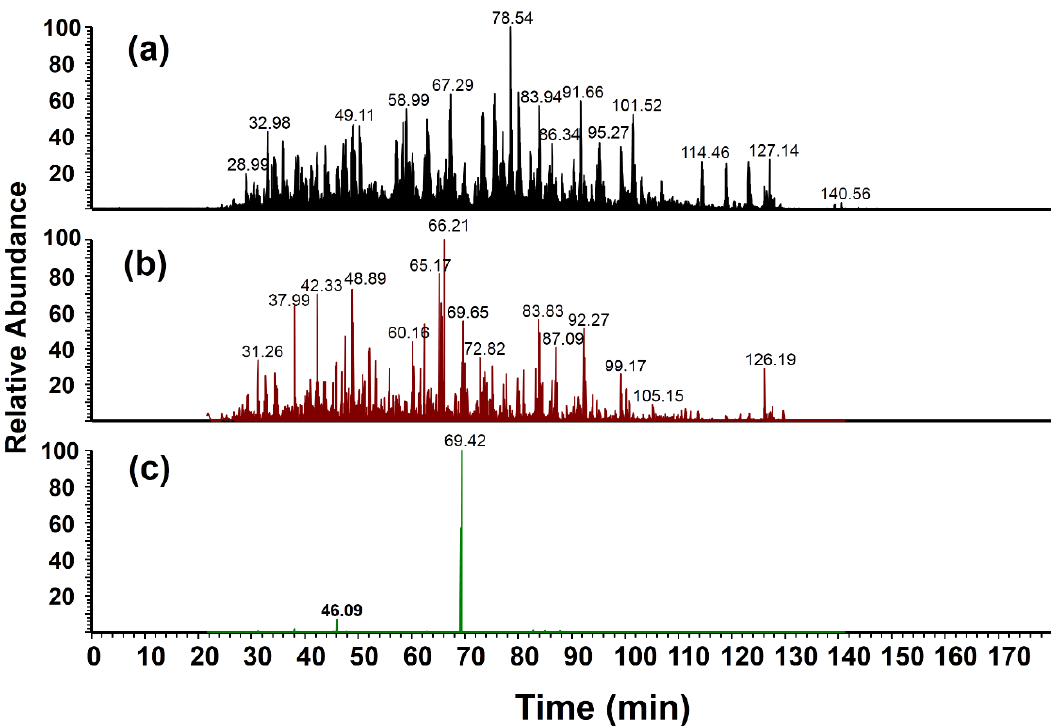
Figure 4. ( a ) Base peak ion chromatogram obtained from liquid chromatography (LC)-MS/MS analysis of a microglial cell lysate digest with nitro-BSA mixture (0.25:1 (light:heavy)) added; ( b ) Reconstructed ion chromatogram showing MS/MS spectra that contain the m / z 182 peak with a detection mass tolerance of ±1.0 Da ( m / z 181.0–183.0); and ( c ) Reconstructed ion chromatogram showing MS/MS spectra with high mass accuracy detection of the m / z 182 peak ( m / z